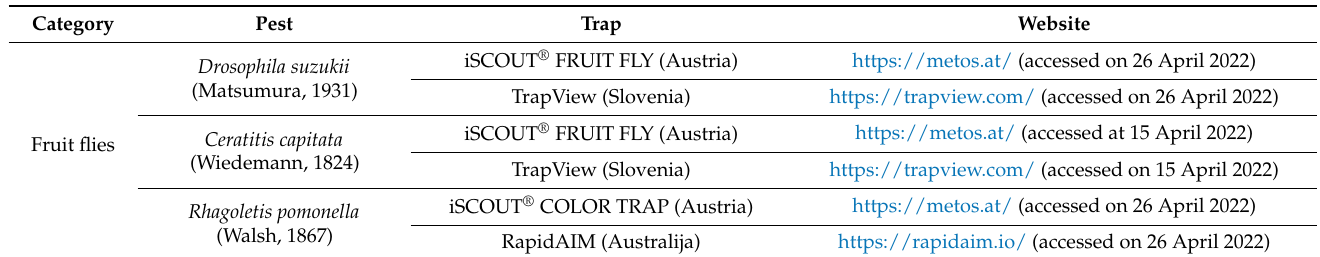
Table 2. Commercially available devices for automatic monitoring of fruit flies (Tephritidae and